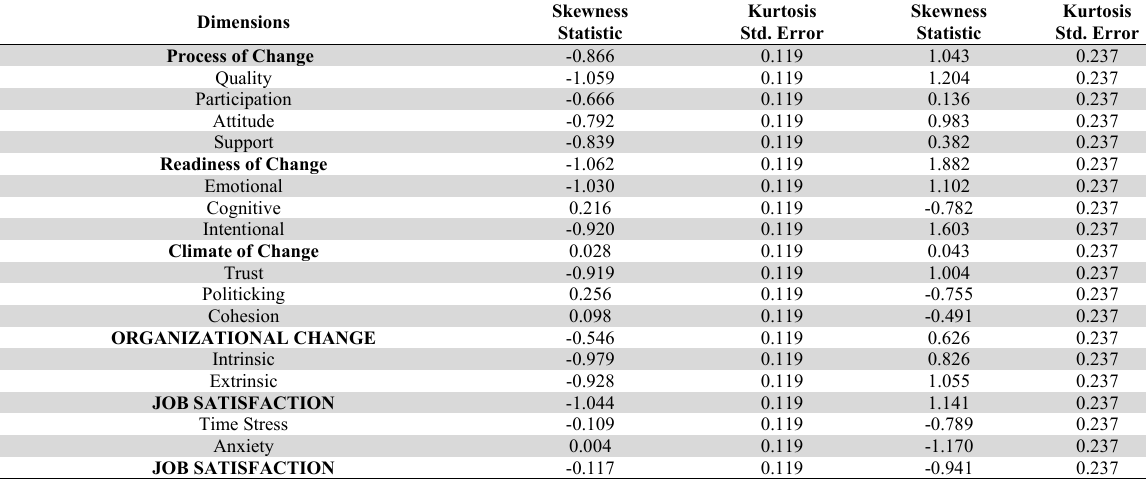
Test of Normality Dimensions